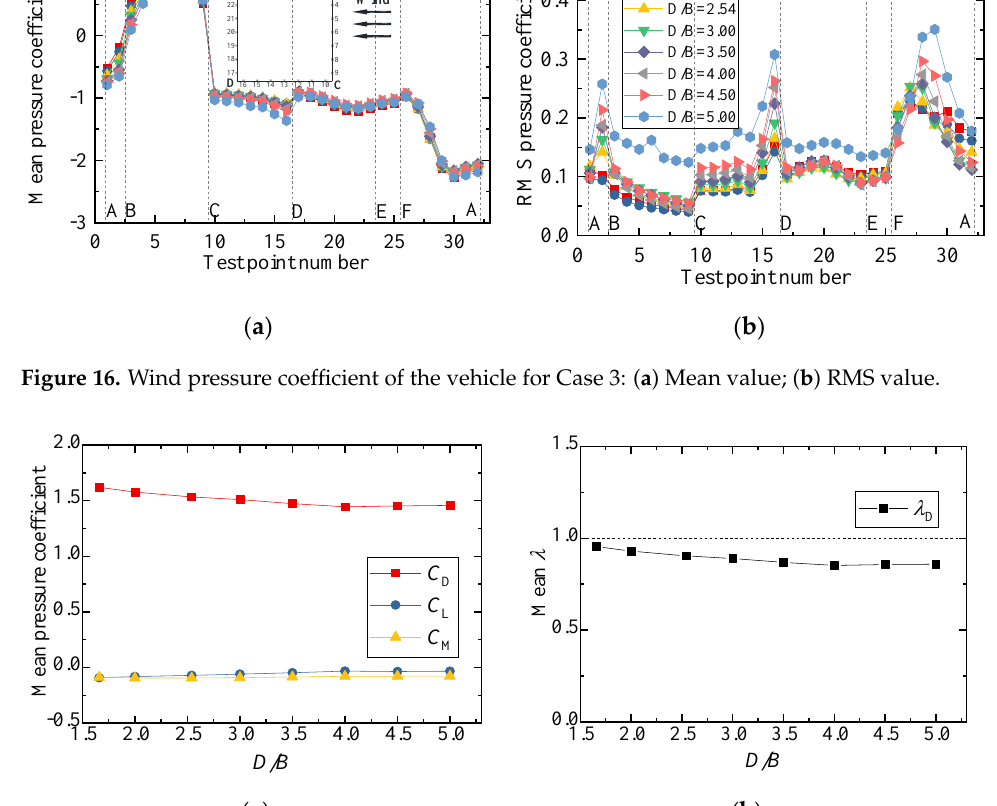
Figure 17. Comparison of the ( a ) aerodynamic coefficients and ( b ) interference factor for the upstream bridge for the various D/B ratios investigated in Case 3.